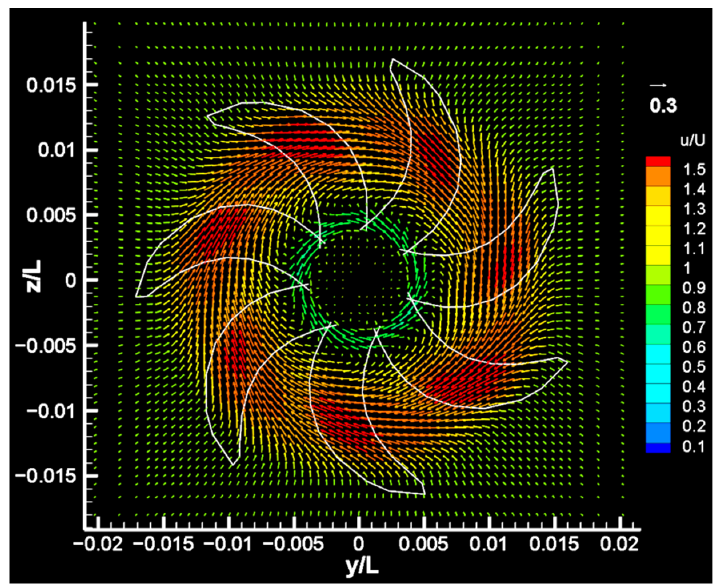
Figure 16. Vector field solved by the rotating blade propeller model for E1619 propeller. The vectors are colored by the axial velocity.